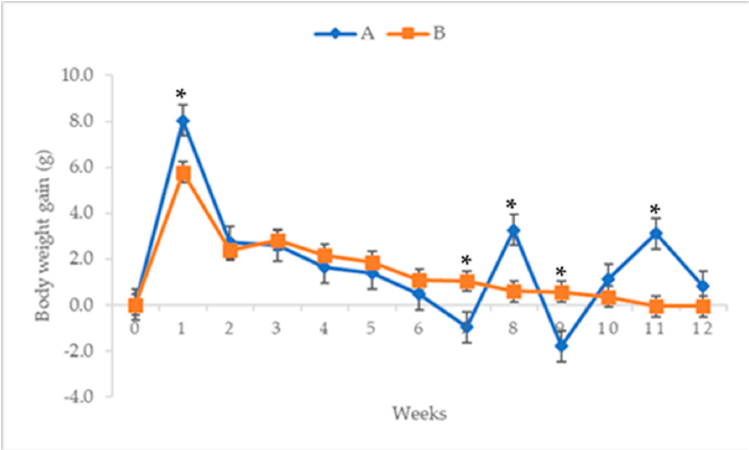
Figure 1. Average (mean ± SEM) weekly bodyweight gain (g) of male Institute of Cancer Research (ICR)-mice injected with 80 mg/kg n -ethyl- n -nitrosourea (ENU) twice at one-week interval. Key: A = control, B = treated with 80 mg/kg ENU twice with a 1-week interval, * significantly different at p < 0.05, SEM = standard error of mean.